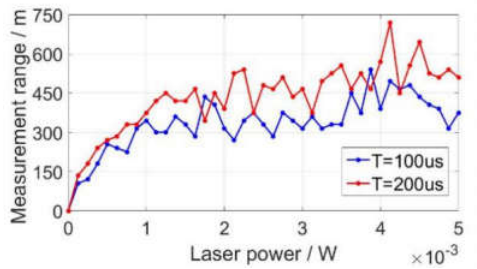
accumulative times will tend to